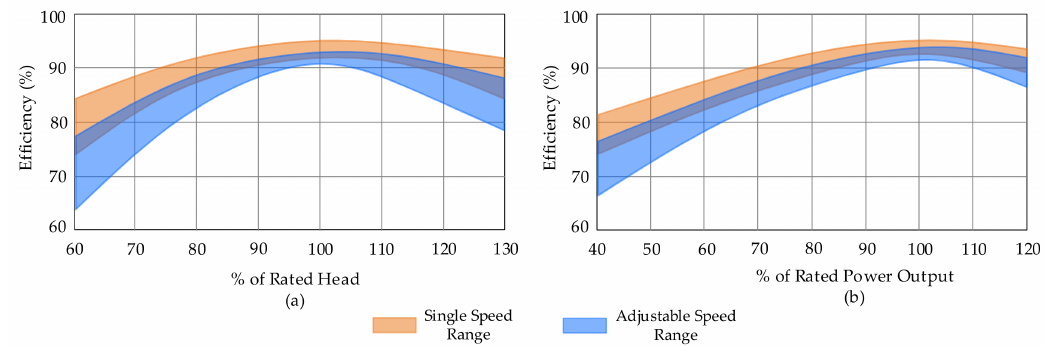
Figure 2. Hydraulic turbine e ffi ciency (%) versus: ( a ) rated head (% of the rated value) and ( b ) rated power output (% of the rated output power), considering fixed-speed and variable-speed